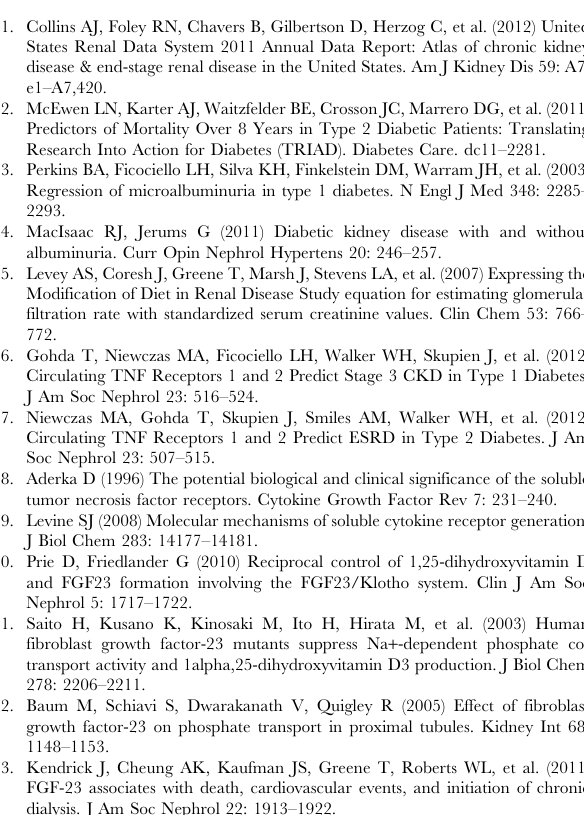
Table S3 Spearman correlation coefficients among clinical variables and plasma markers at